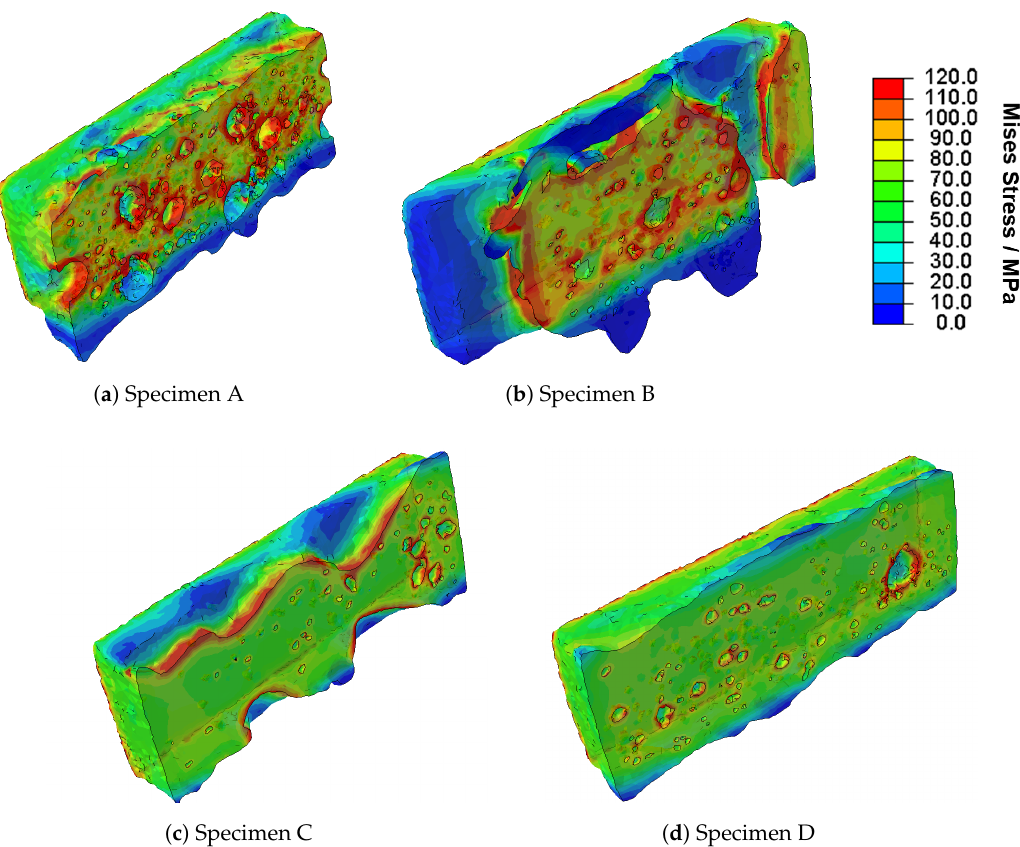
Figure 8. Results of the FE-simulation of the selected welds under a concentrated load of F = 3kN; Mises stress shown in pseudo-colour. The welds are presented in the form of longitudinal cuts across the centre of the